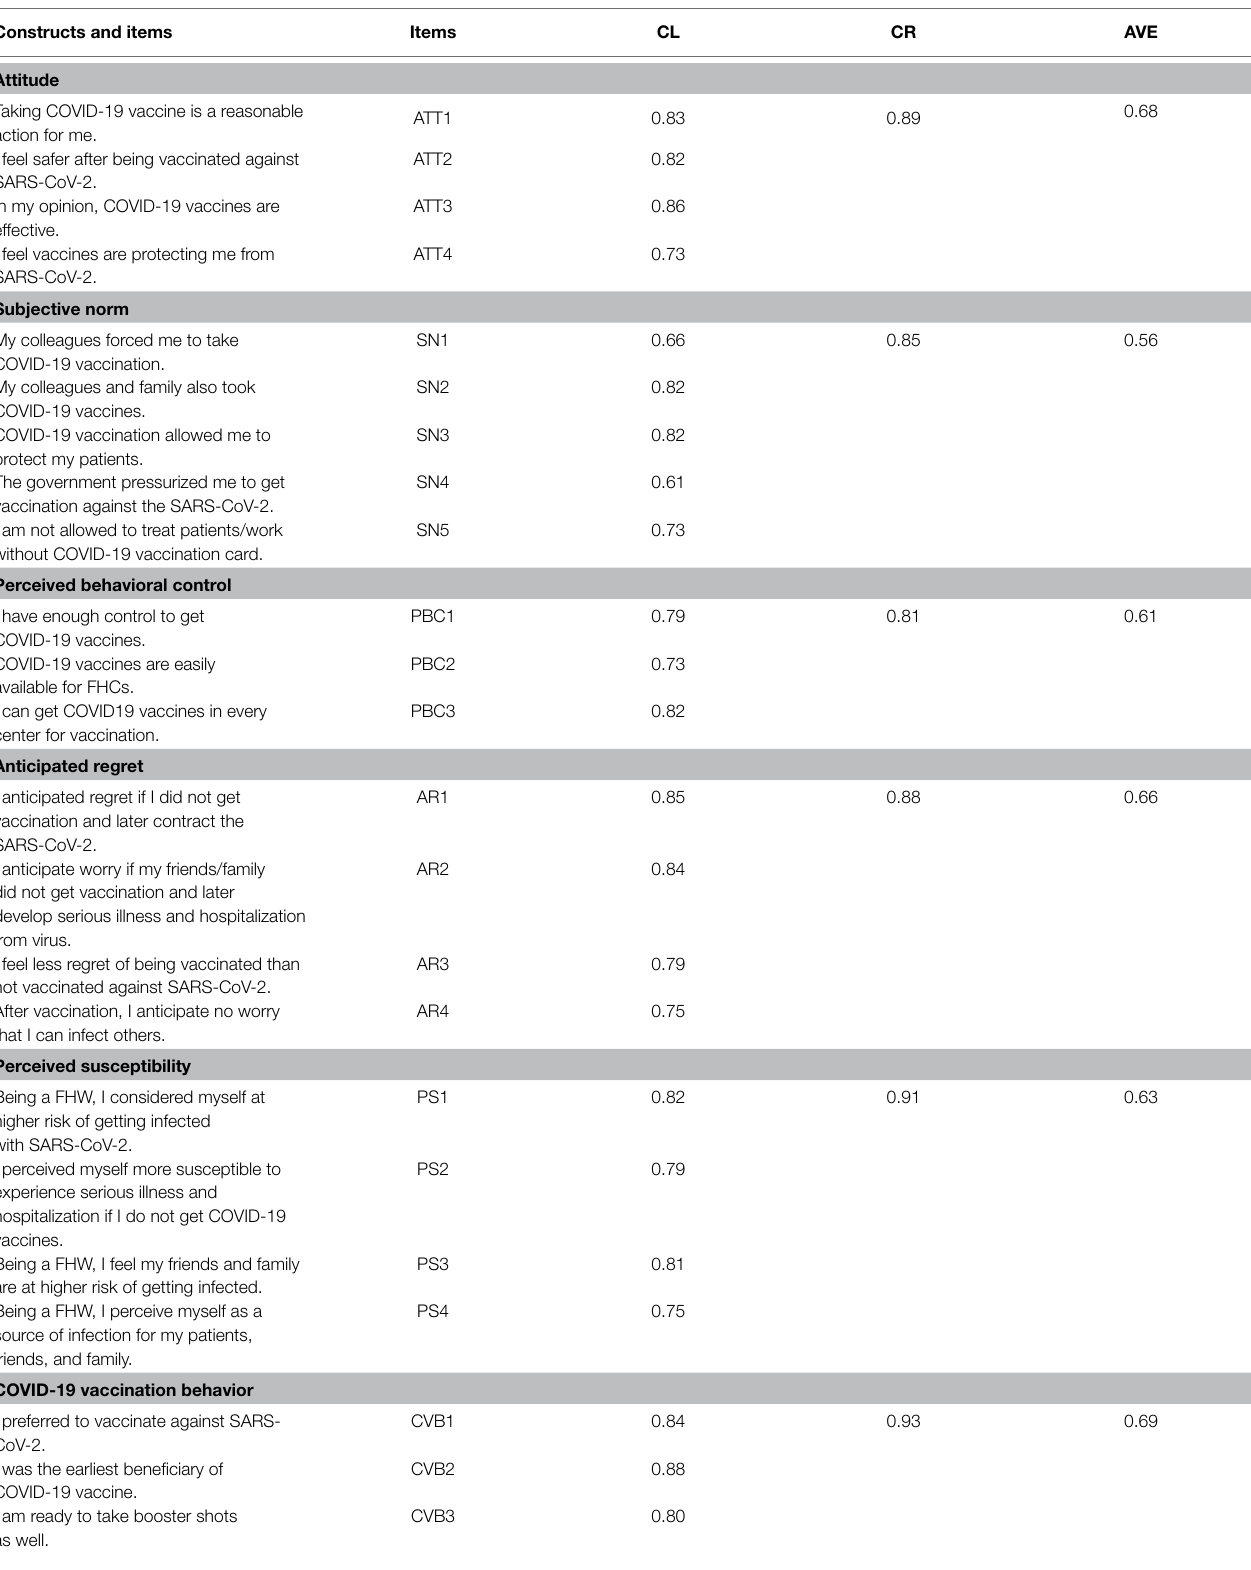
TABLE 3 | Assessment of convergent validity ( n =